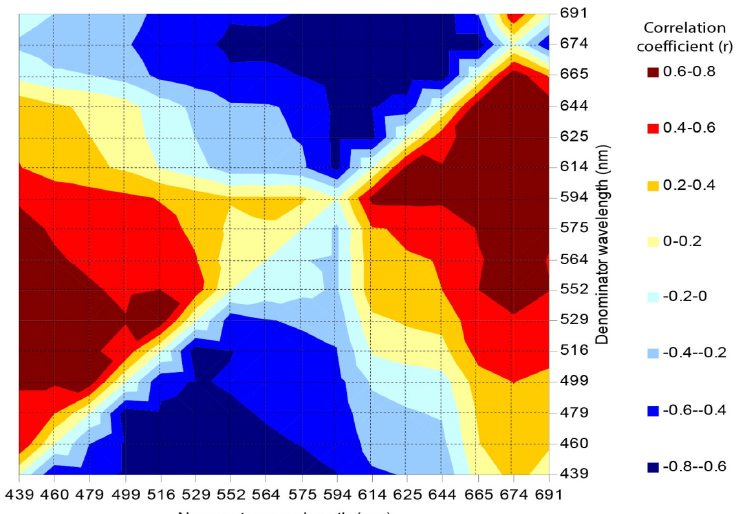
Figure 7. Correlation coefficients between simple band ratios and coral